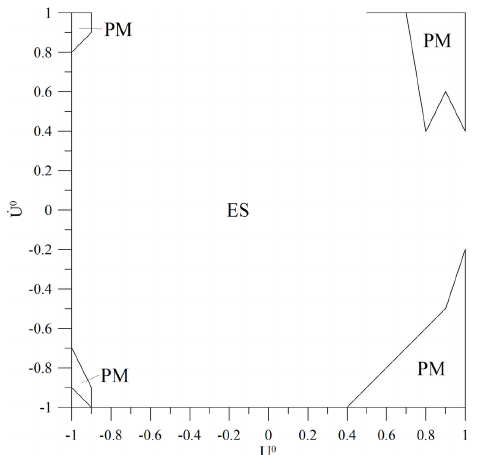
Fig. 12. Calculation of maximal Lyapunov exponent by perform- ing additional averaging over a set of different initial conditions, Fig. 13. Domains of initial conditions ( ˙ U 0 ∈ ,U 0 , ˙ U 0 , ˙ U 0 whereby U 0 belong to the respective ranges U 0 = U 0 ) admitting equilibrium state (ES) or periodic motion U 0 1 2 1 2 1 2 [ 0 , 0 . 003 ] ,U 0 ∈ [ 0 , 0 . 05 ] , ˙ U 0 ∈ [ 0 , 0 . 003 ] ,U 0 ∈ [ 0 , 0 . 07 ] . The re- (PM). The results are obtained for the parameter set c 1 = c 2 = 0.1, 2 1 2 sults have been obtained by the method of Wolf et al. (1985). Max- τ 1 = τ 2 = 3.0. Diagram is constructed for the step size equal of imal Lyapunov exponents converge well to positive values of the 0.1 for both ˙ U 0 and U 0 . The remaining parameter values are: = ν c = 1, k = k = k = order 10 − 3 , the same as in Fig. 11. Note that time t is expressed in ν c 1 2 1 2 the units of iteration steps.